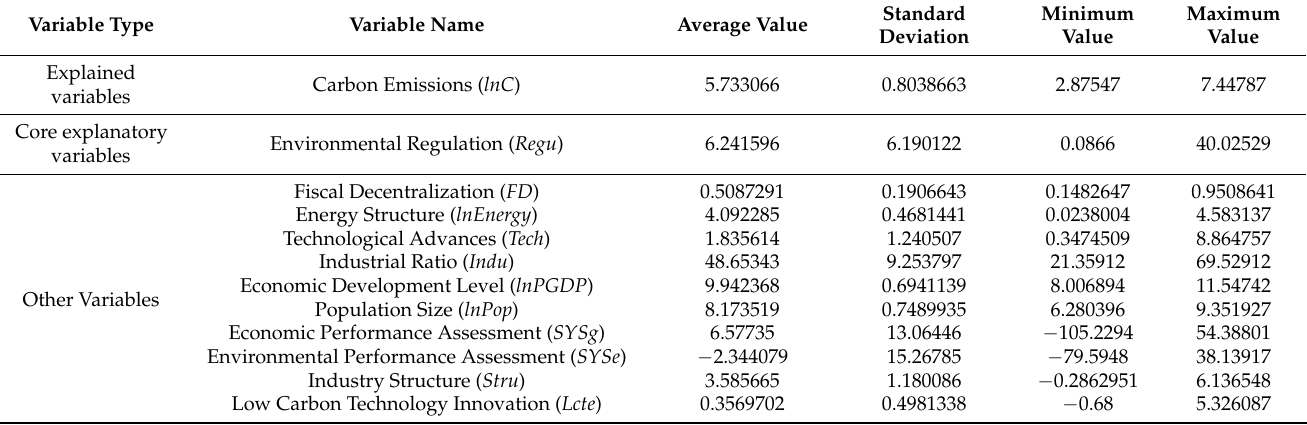
Table 8. Descriptive statistics of the variables (N =